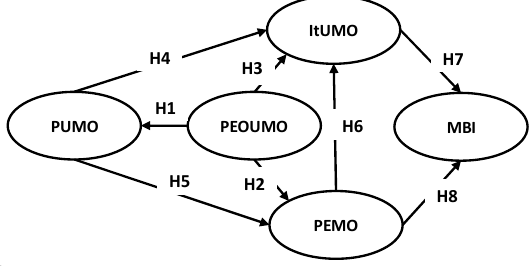
Fig. 1. Research Framework and